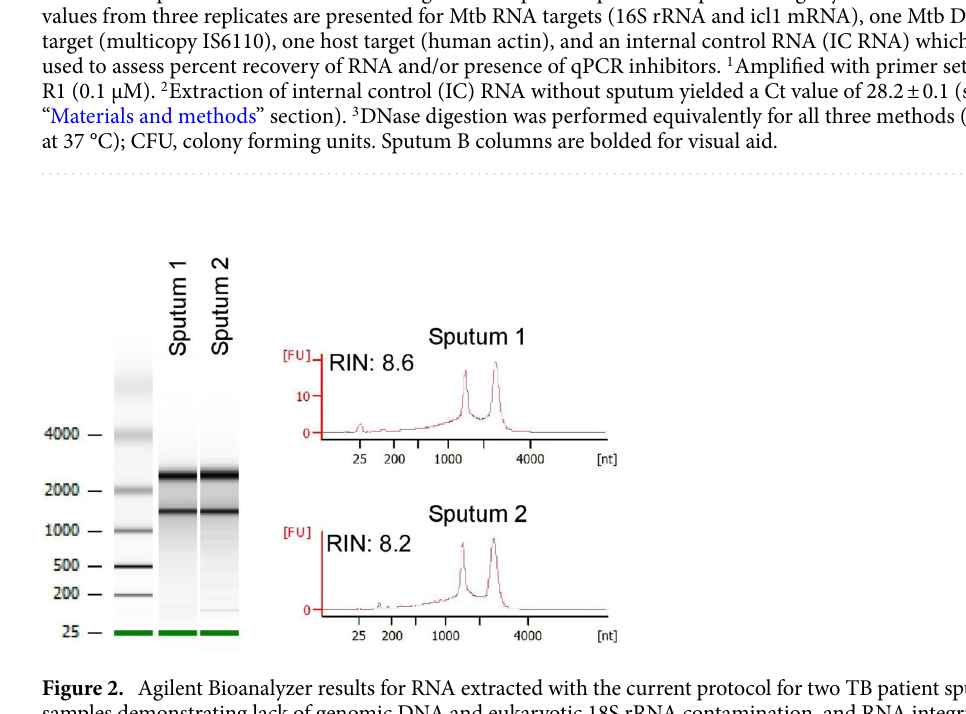
Figure 2. Agilent Bioanalyzer results for RNA extracted with the current protocol for two TB patient sputum samples demonstrating lack of genomic DNA and eukaryotic 18S rRNA contamination, and RNA integrity numbers (RIN) of >